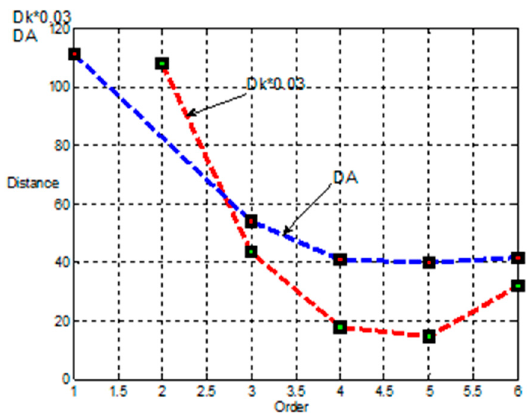
Figure 5. Dependencies of Mahalanobis distance on the order of statistical moments.